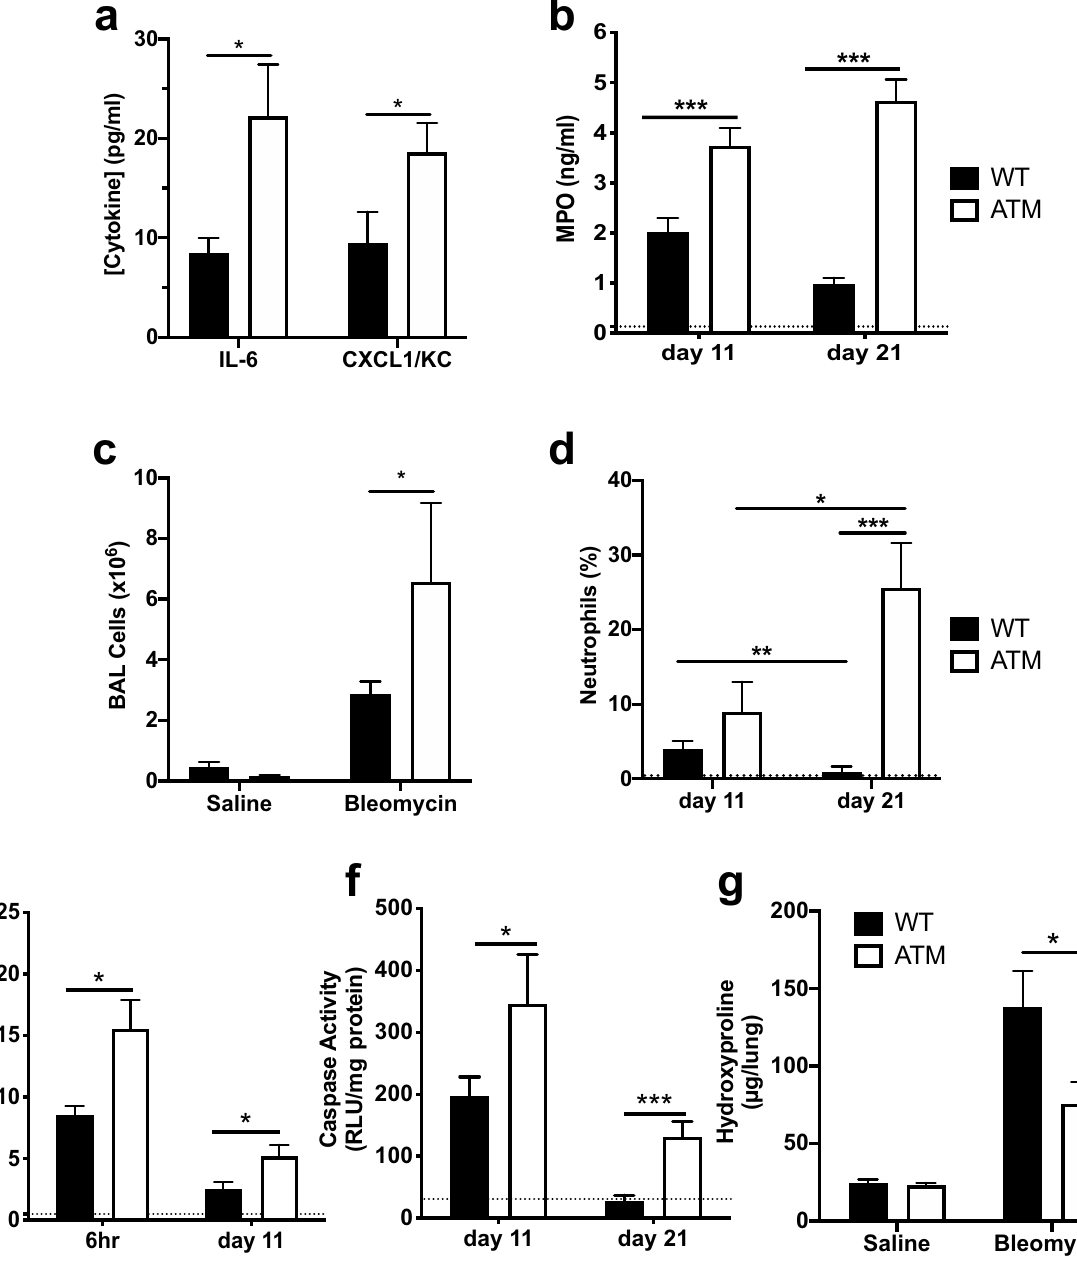
Figure 2. ATM-deficiency leads to exaggerated inflammatory responses and increased apoptosis in response to acute lung injury. ( a ) Levels (pg/mL) of the pro-inflammatory cytokine, IL-6, and the neutrophil attractant chemokine, KC/CXCL1, were quantitated in BAL supernatants from bleomycin treated WT and ATM-deficient mice at d21 by ELISA using mouse recombinant proteins as standards. ( b ) BAL myeloperoxidase levels (MPO, ng/mL) were assessed by ELISA at d11 and d21 post-bleomycin instillation. Dotted line, MPO levels in BAL fluid of saline-treated control animals. ( c ) Live BAL cells (× 10 6 ) were quantitated by counting using a hemocytometer and staining with the viability dye, Trypan Blue. Saline vs. bleomycin cell numbers: P ≤ 0.001 for WT; P ≤ 0.05 for ATM ∆/∆ . ( d ) Percentages of neutrophils in the BALs from WT and ATM ∆/∆ mice were assessed by flow cytometry at d11 and d21 post-bleomycin. dotted line, % neutrophils in control saline-instilled BALs. Number of animals for A-D: d11: WT, n = 11; ATM ∆/∆ , n = 8; d21: WT, n = 11; ATM ∆/∆ , n = 5. ( e ) Percentages of TUNEL positive cells in 10 arbitrarily selected microscopic fields of lung sections of WT and ATM deficient mice at 6 h and d11 post-bleomycin instillation were quantitated using ImageJ software in a blinded manner. Number of animals: 6 h: WT, n = 5; ATM ∆/∆ , n = 7; d11: WT, n = 10; ATM ∆/∆ , n = 10. Dotted line, % TUNEL + cells in control saline-instilled lungs. ( f ) Caspase 3/7 activity in lung homogenates from WT and ATM ∆/∆ mice at d11 and d21 post-bleomycin instillation was determined using a luminescence-based assay (Promega). Number of animals: d11: WT, n = 12; ATM ∆/∆ , n = 7; d21: WT, n = 10; ATM ∆/∆ , n = 8. Bars, mean ± SEM; *P ≤ 0.05; ***P ≤ 0.001. Dotted line, caspase activity in control saline-instilled lungs. ( g ) Levels of hydroxyproline (μg/ lung) were quantitated in lung homogenates using the acid hydrolysis Woessner method at d21 post-bleomycin. WT + saline, n = 6; WT + BLM, n = 11; ATM ∆/∆ + saline, n = 5; ATM ∆/∆ + BLM, n = 9; bars, mean ± SEM; *p ≤